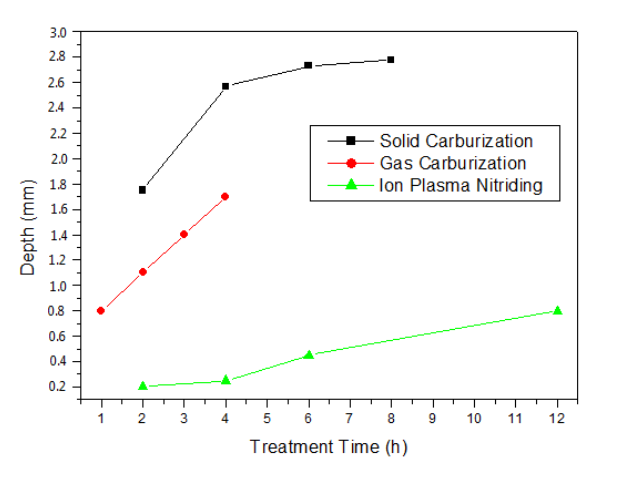
Figure 6 – Layer depth as a function of the time of applied thermochemical treatment